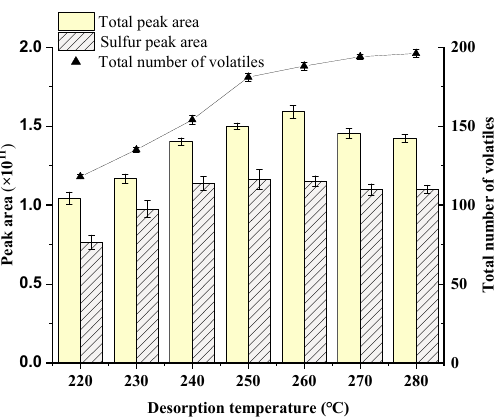
Figure 6. Effect of desorption temperature on the extraction efficiency of the VOCs.